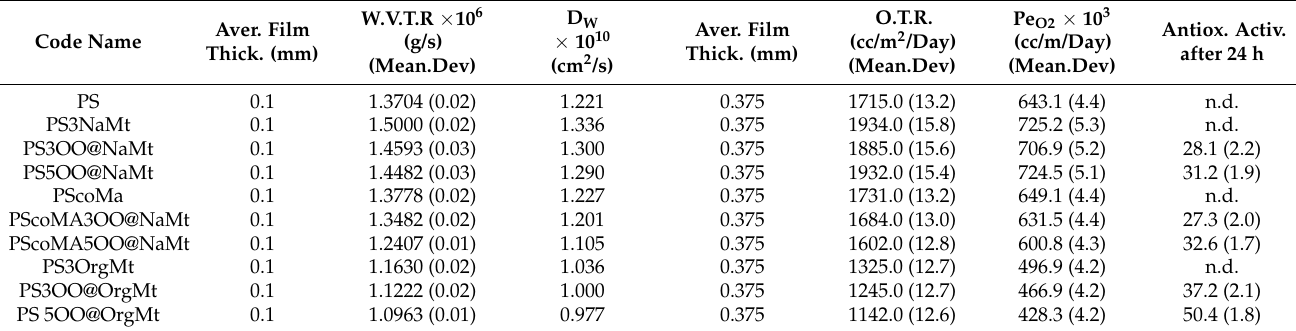
Table 4. Average films thickness, Water Vapor Transmission Rate (WVTR), water sorption, obtained Oxygen Transmission Rate (O.T.R.), Oxygen Permeability (Pe O2 ), and Antioxidant Activity values of all tested films. Aver. Film Code Name Thick.